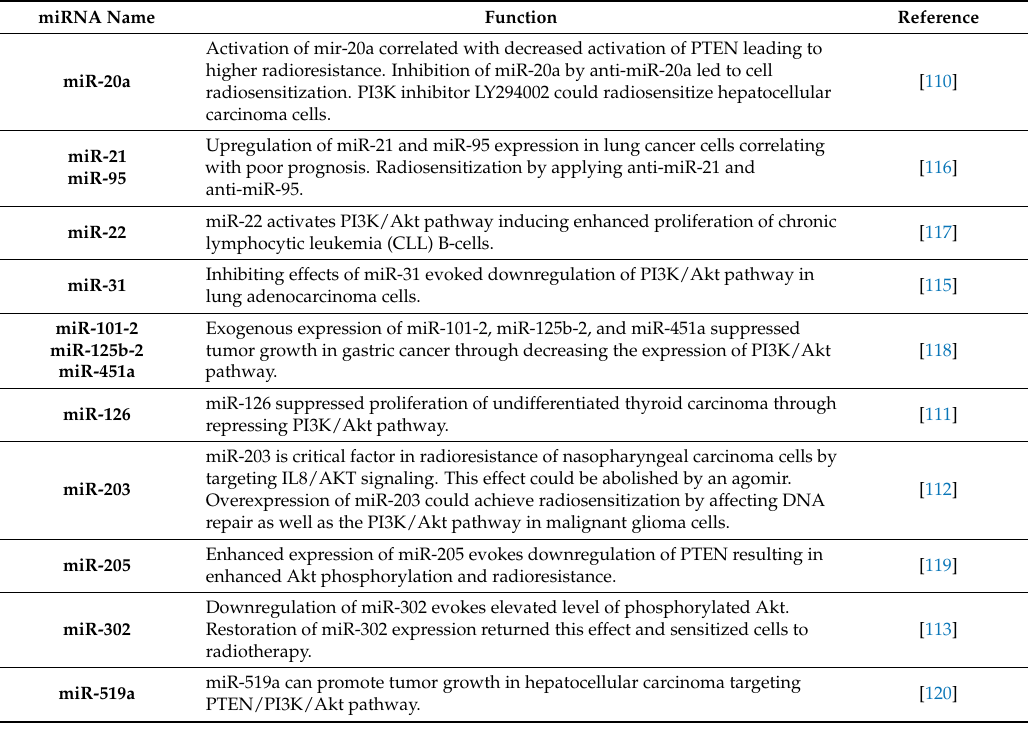
Table 1. Regulation of the PI3K/Akt pathway with